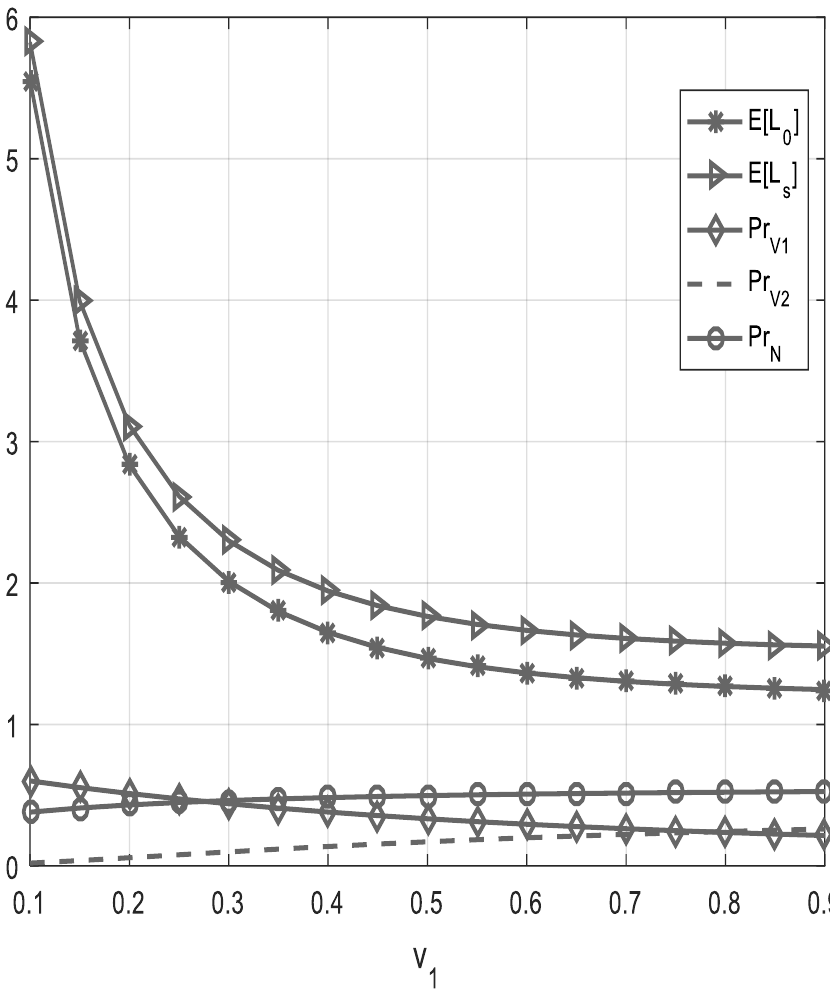
Figure3.Effect of rate of type I vacation ( 𝑣 ) on system performance measures. 1 From figure 3, we see that as the type I vacation rate increases, the expected length of orbit, expected length of system and probability of type I vacation decrease but the probability of type II vacation and probability of normal (active) state increase. The fact behind the observation is that with the increase in type I vacation rate, the duration of type I vacation decreases and this causes increase in probability of normal state and the probability of type II vacation. Due to which the expected number of customers in orbit and that in the system